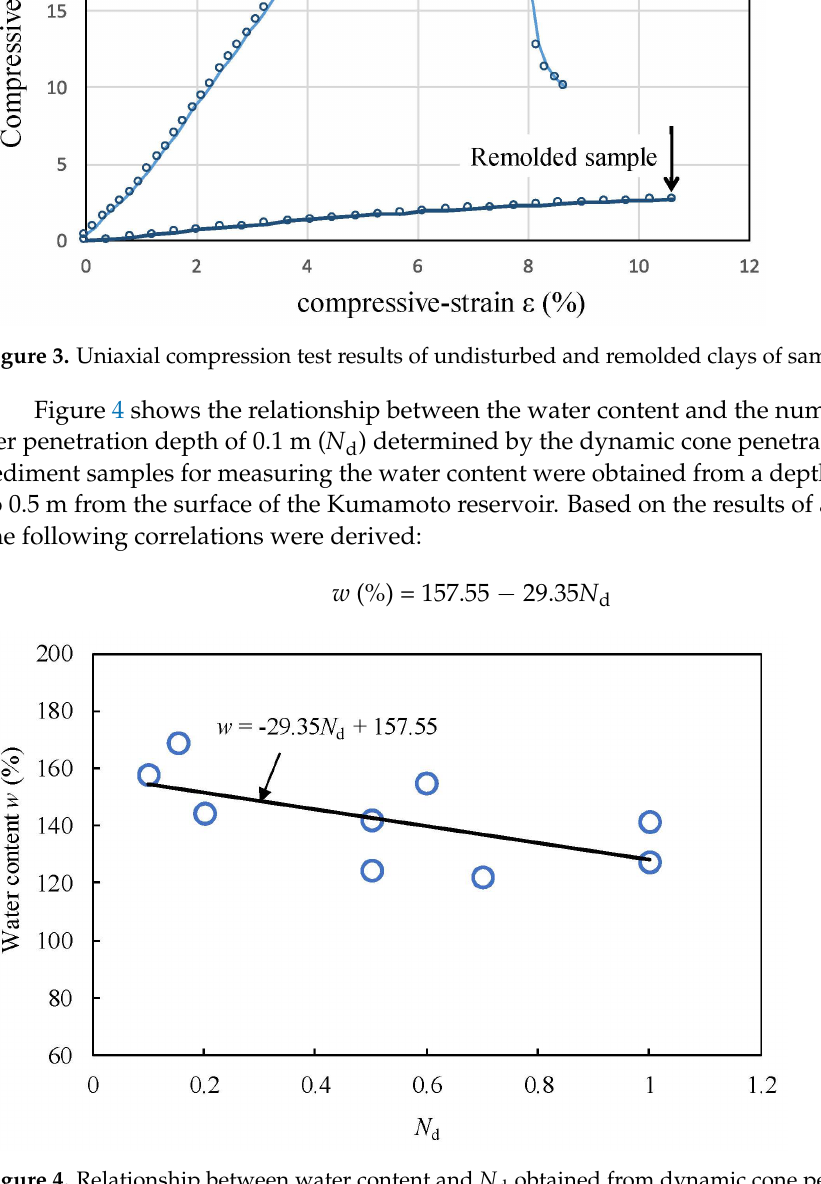
Figure 4. Relationship between water content and N d obtained from dynamic cone penetration